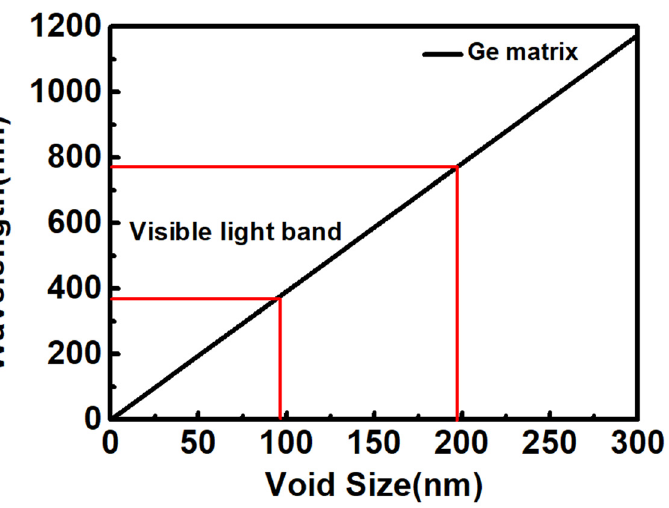
Figure 1. Relationship between central reflection wavelength ( λ IO ) of the IO structure ( λ IO ) based on Ge matrix and void sizes ( D void ) of the system.